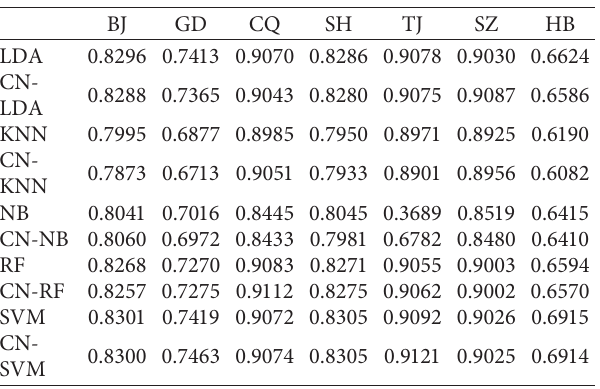
Figure 5: Comparison of the predicted results of different forecasting models on the fluctuation trend of carbon price in China’s carbon market. Table 4: The average prediction accuracy of China’s pilot carbon